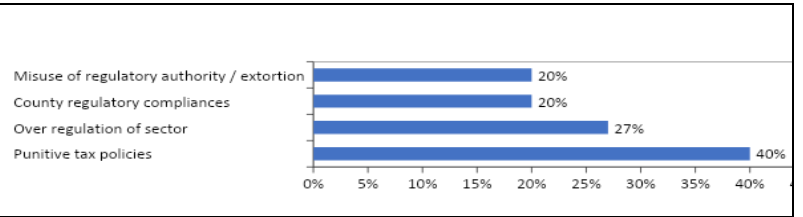
Figure 19: Policy and Regulatory